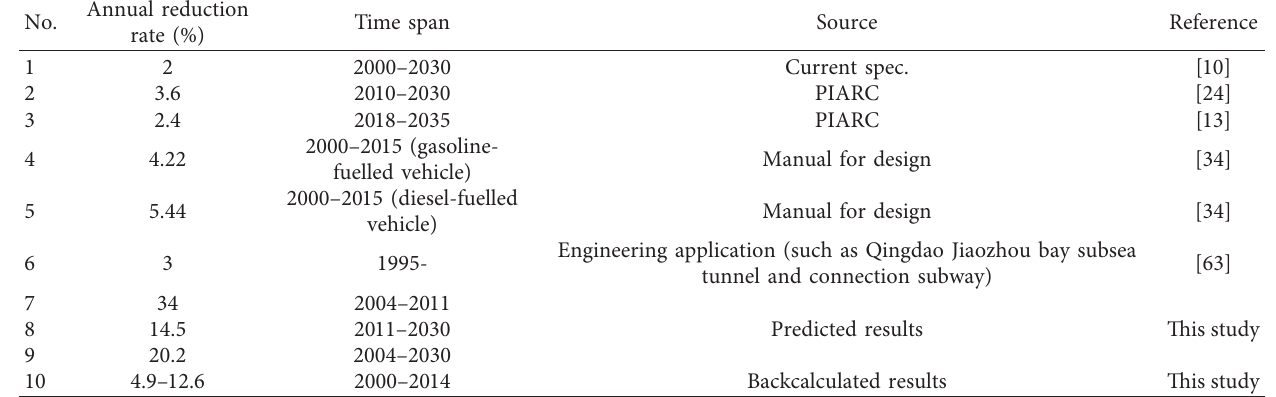
Table 7: The summary of time factors of CO-based emission factors in